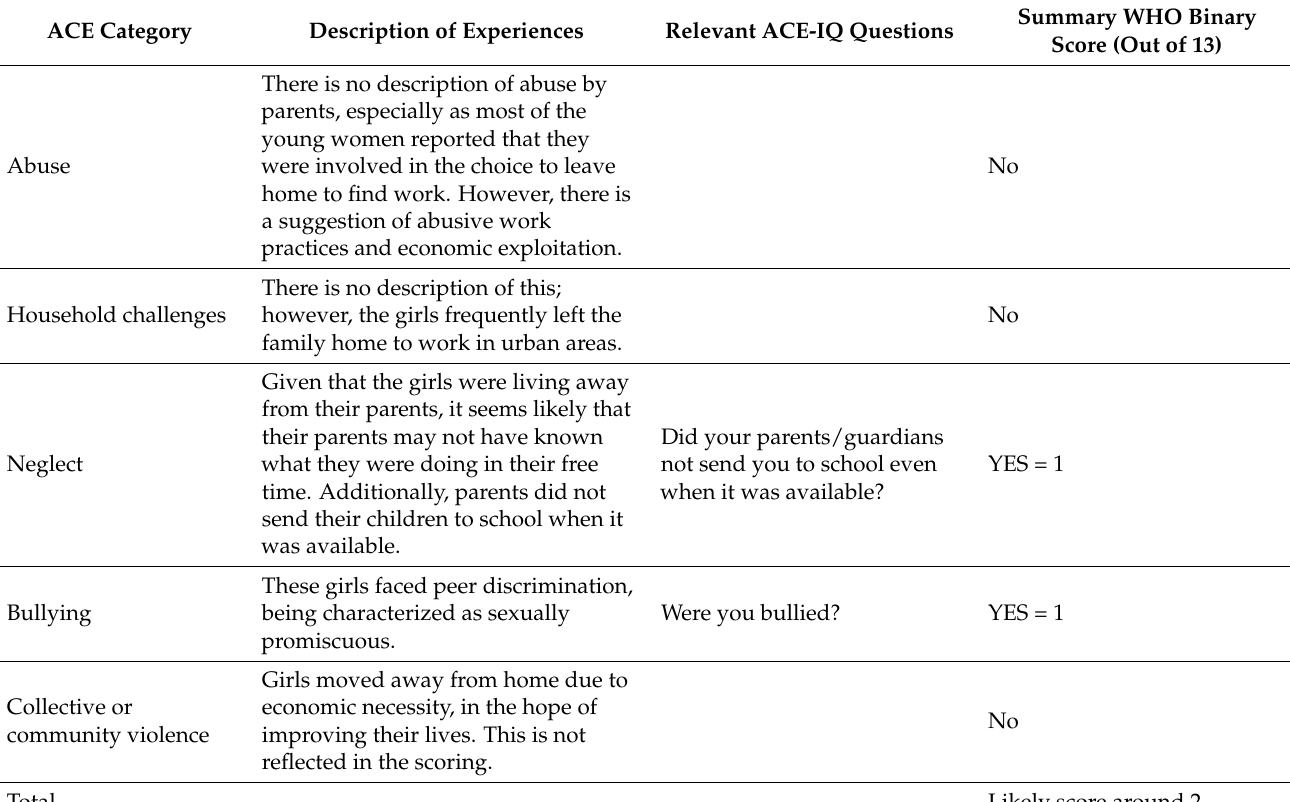
Table 3. Garment factory in